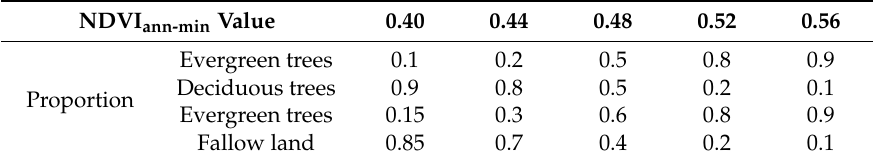
Table 3. Relationship between the annual minimum normalized difference vegetation index (NDVI ann-min ) and proportion of evergreen trees in corresponding mixed pixels. The NDVI ann-min value changes as the proportion of evergreen trees in the pixel changes.